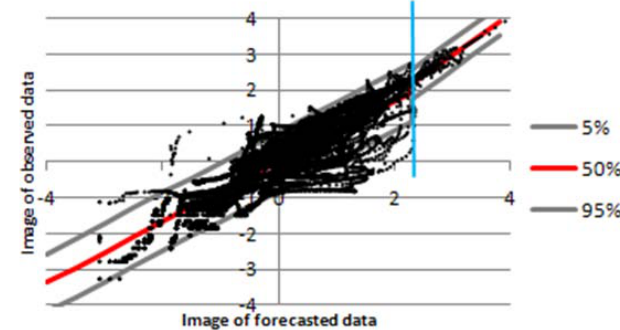
Fig. 4. Truncated normal joint distributions. The division of the Joint Distribution in the normal space into two bivariate truncated normal distributions is shown. The red line represents the modal value, while the grey lines represent the 5% and the 95% quantiles. The light blue line represents the threshold used in order to identify the two